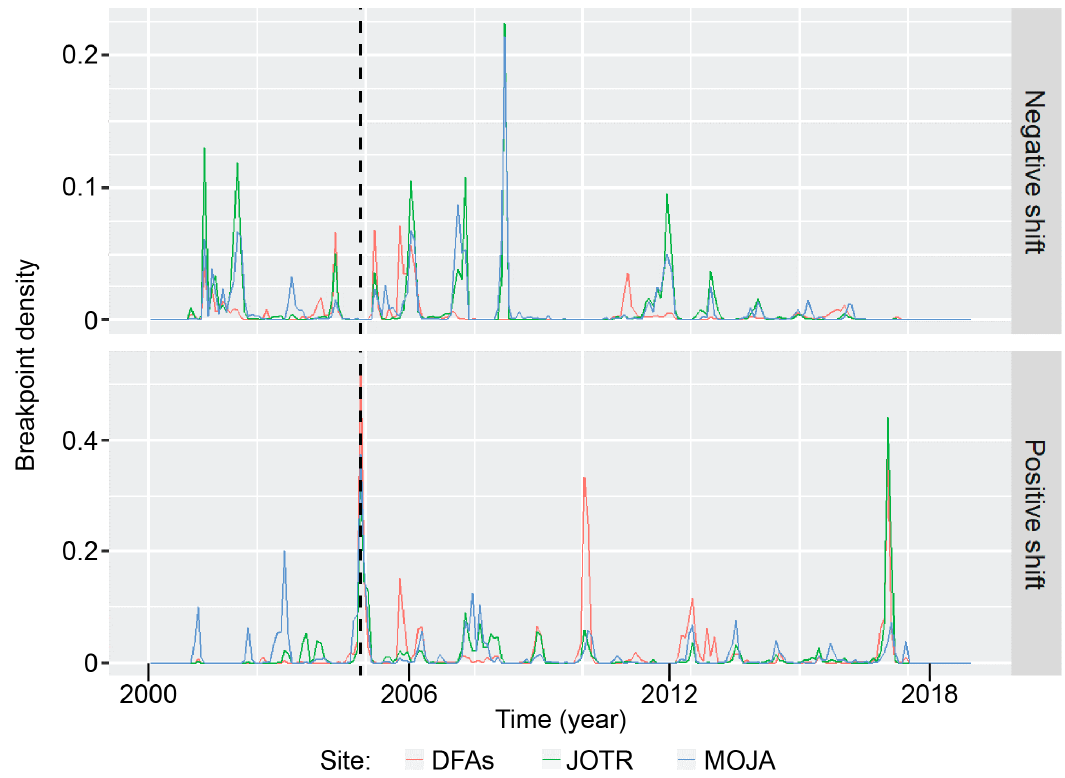
Figure 8. Time series of positive and negative breakpoint density for study areas. Environments 2019 , 6, x FOR PEER REVIEW